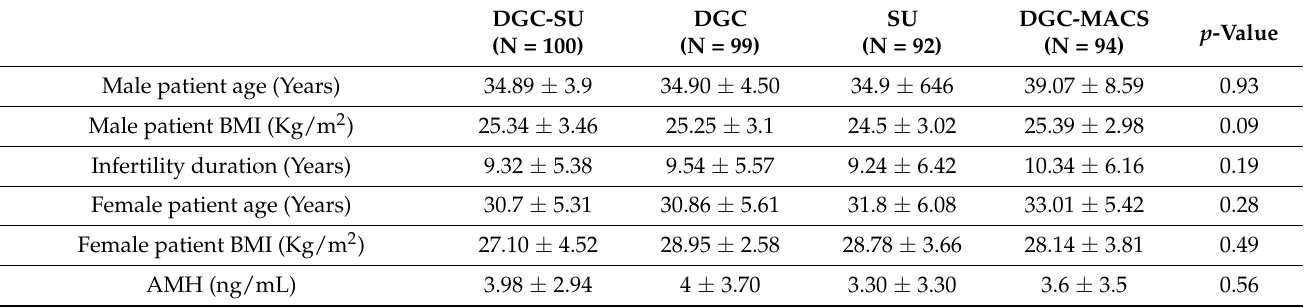
Table 1. Male patient age, male patient body mass index (BMI), female patient age and anti-Mullerian hormone (AMH) in the whole studied population of patients with